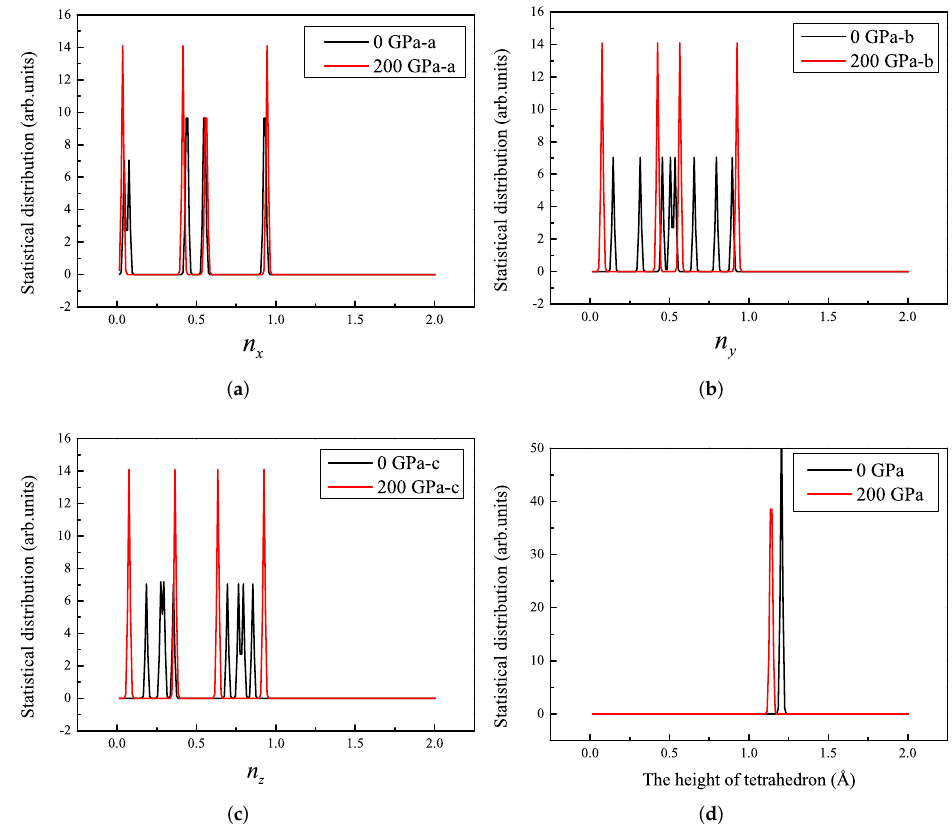
Figure 3. Statistical distribution of components of the unit vector in the normal direction on the surface of tetrahedron N 4 for 2-Td-N 4 under 0 GPa and 200 GPa: ( a ) n x , ( b ) n y , ( c ) n z ; ( d ) statistical distribution of the heights of the tetrahedron N 4